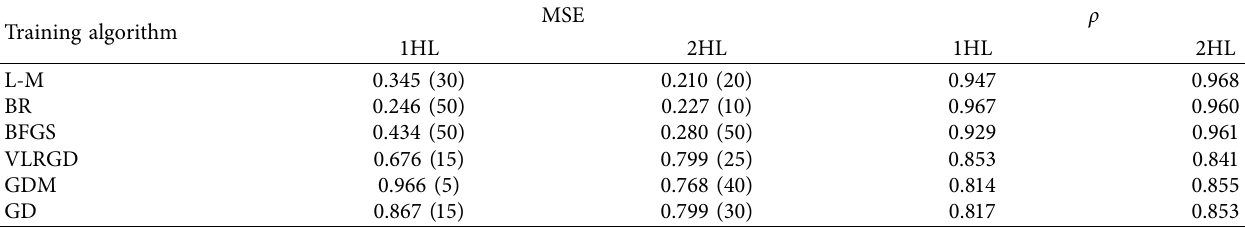
Table 2: Best FFNN models identified in the validation stage with 1 and 2 hidden layers.